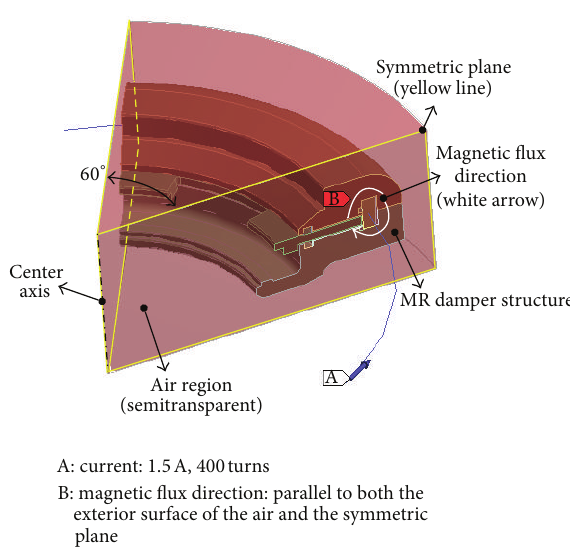
Figure 5: Load and boundary